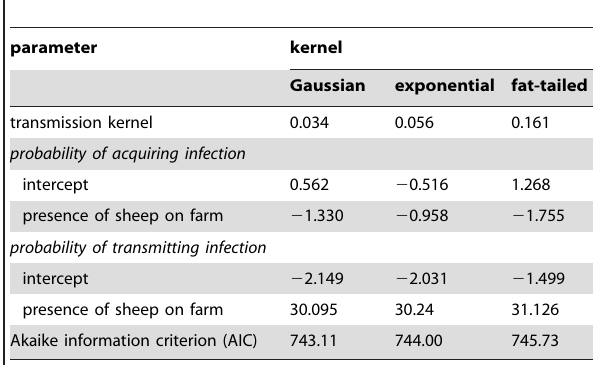
Table 4. Maximum-likelihood estimates for the probability of transmission between farms when fitted to data on the spread of BTV in northern Europe during